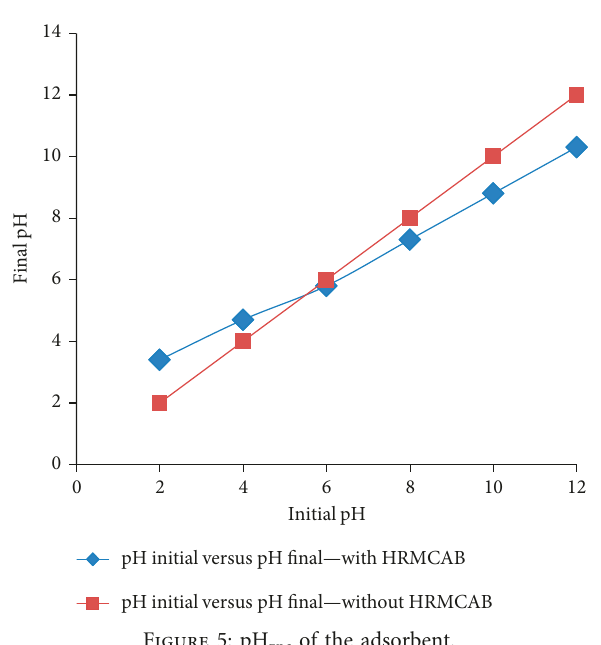
Figure 5: pH zpc of the